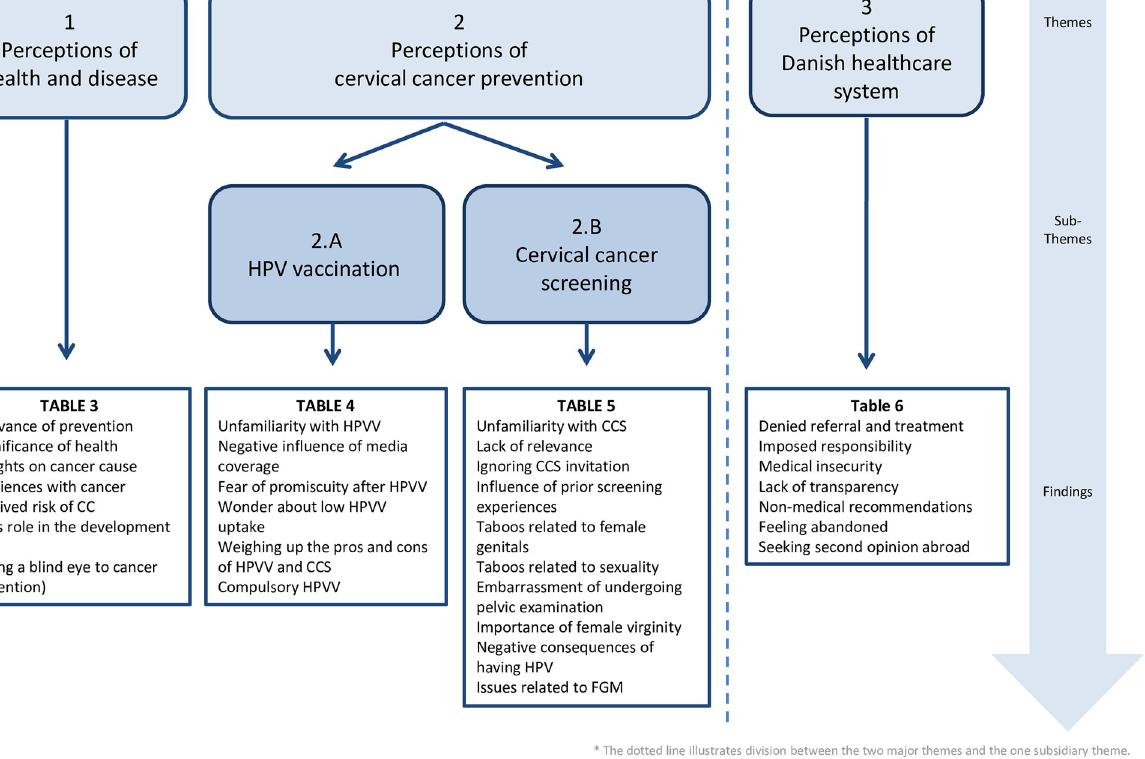
PLOS ONE | https://doi.org/10.1371/journal.pone.0250816 June 1,